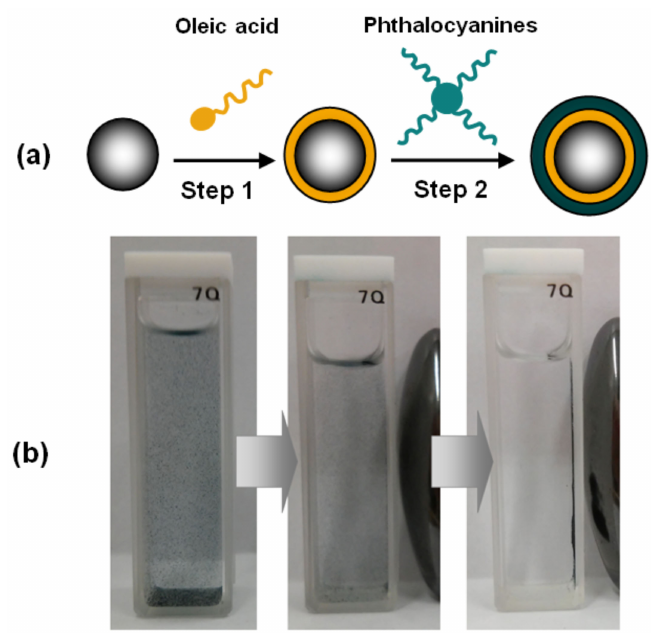
Figure 8. ( a ) Schematic representation of preparation of magnetic phthalocyanines: Step 1) ferrofluid produced with the mixture of Fe 3 O 4 and oleic acid; Step 2) reaction of ferrofluid with phthalocyanines. ( b ) Influence of the magnetic field under the suspension of Fe 3 O 4 @OA / Pc in